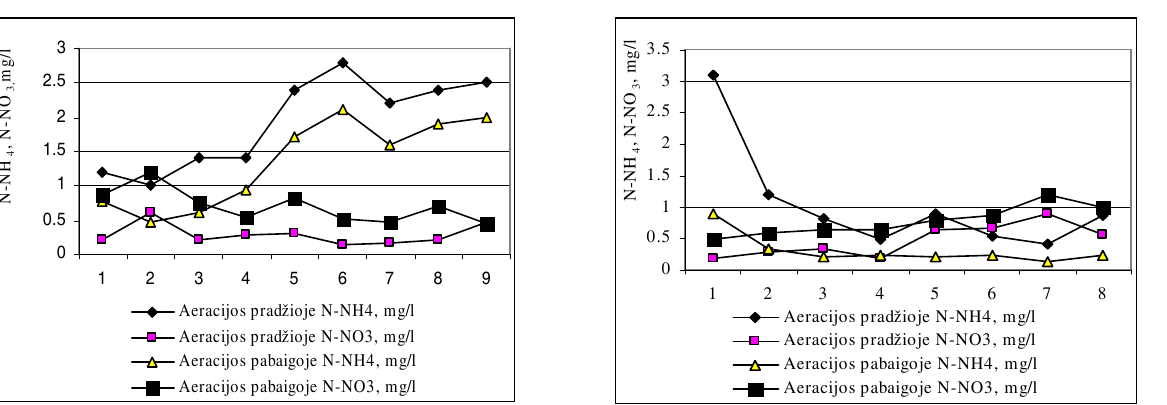
Fig 3. Concentration change of ammonium nitrogen and nitrates in the first aeration tank in the beginning and at the end of aeration at aeration and reduced aeration rate of 150 min